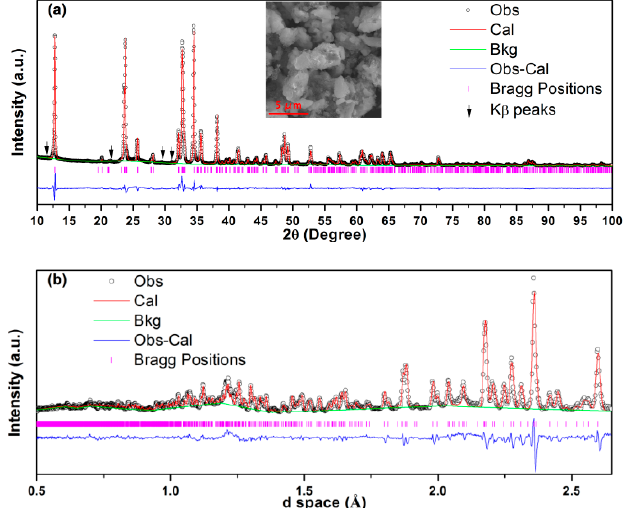
Figure 2. Combined Rietveld refinement of the ( a ) XRD (R wp = 8.04%, R p = 6.20%) and ( b ) neutron di ff raction (ND) (R wp = 6.82%,R p = 5.39%) patterns of Na 3 V(PO 4 ) 2 . Arrows in the XRD pattern indicate residual Cu K β peaks caused by the di ff ractometer. The overall R wp and R p are 7.45% and 5.73%,